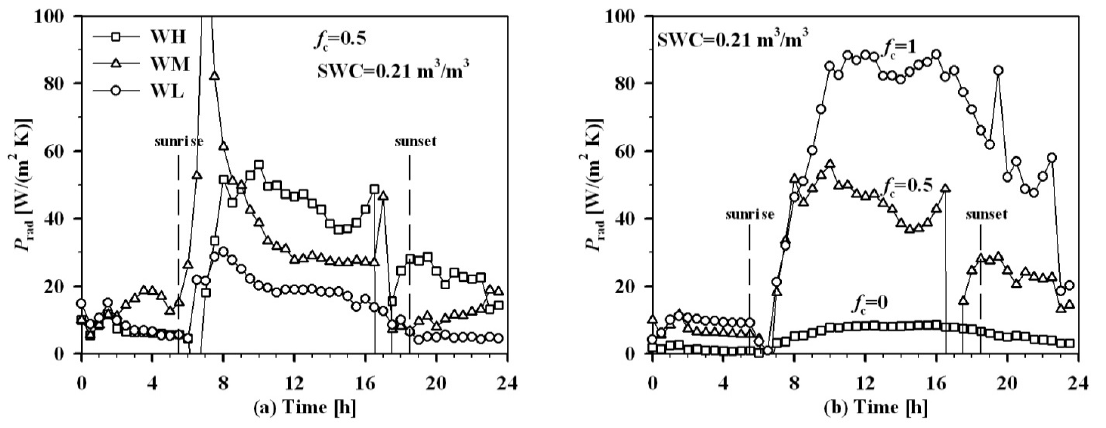
in a diurnal cycle ( a ) for the same atmosphere and surface Figure 2. Variation of P rad conditions but with various wind speeds (Atmosphere forcing data, including air temperature, water vapor pressure, incoming solar radiation, etc. , are from the measurements at the ) is 0.5, and Yucheng station on 24 April 2010 (DOY 114). Fractional vegetation cover ( f c soil water content (SWC) is 0.21 m 3 /m 3 . WH denotes the high wind speed condition, which is from the measurement at the Yucheng station on 24 April 2010, and the maximum wind speed during the day is 6.1 m/s; WM represents the medium wind speed condition from the measurement on 29 May 2010 (DOY 149), and the maximum wind speed is 3.6 m/s; WL denotes the low wind speed condition measured on 21 July 2010 (DOY 202), and the maximum wind speed is 1.3 m/s) and ( b ) for the same atmosphere and wind speed but with different fractional vegetation cover (atmosphere and wind speed are from the measurements at the Yucheng station on 24 April